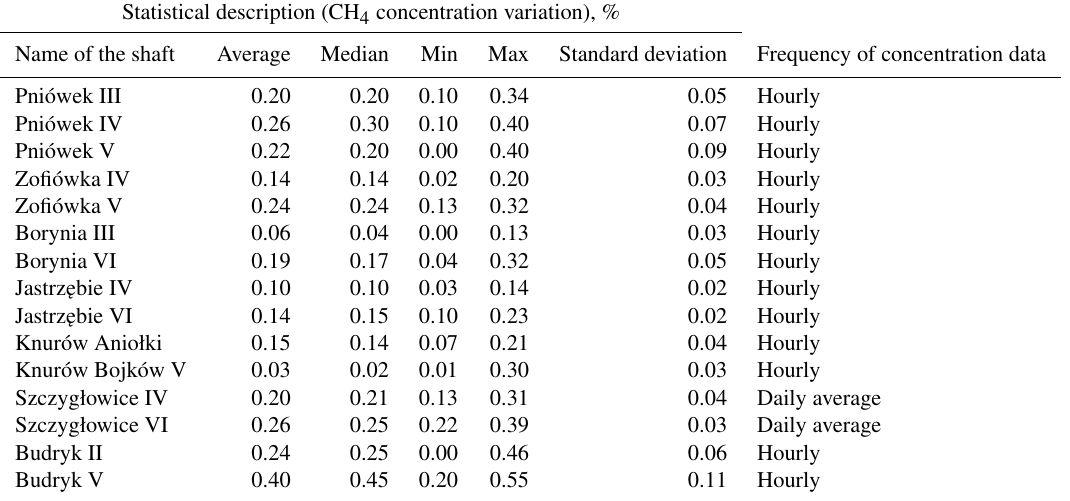
Table 2. The statistical description of methane concentration variation in ventilation shafts under study (period from 14 May to 13 June 2018). Statistical description (CH 4 concentration variation), % Name of the shaft Average Standard